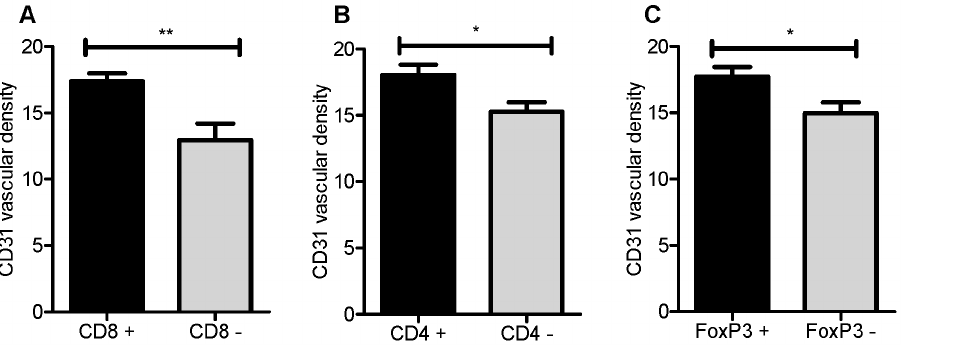
Figure 2. High-grade serous tumors containing TIL have higher vascular density scores than those without TIL. Mean CD31 vascular density scores were compared in relation to expression of (A) CD8, (B) CD4 and (C) FoxP3. Error bars indicate standard error of the mean. Statistical significance was assessed by Mann Whitney test. * p , 0.05, ** p , 0.01.